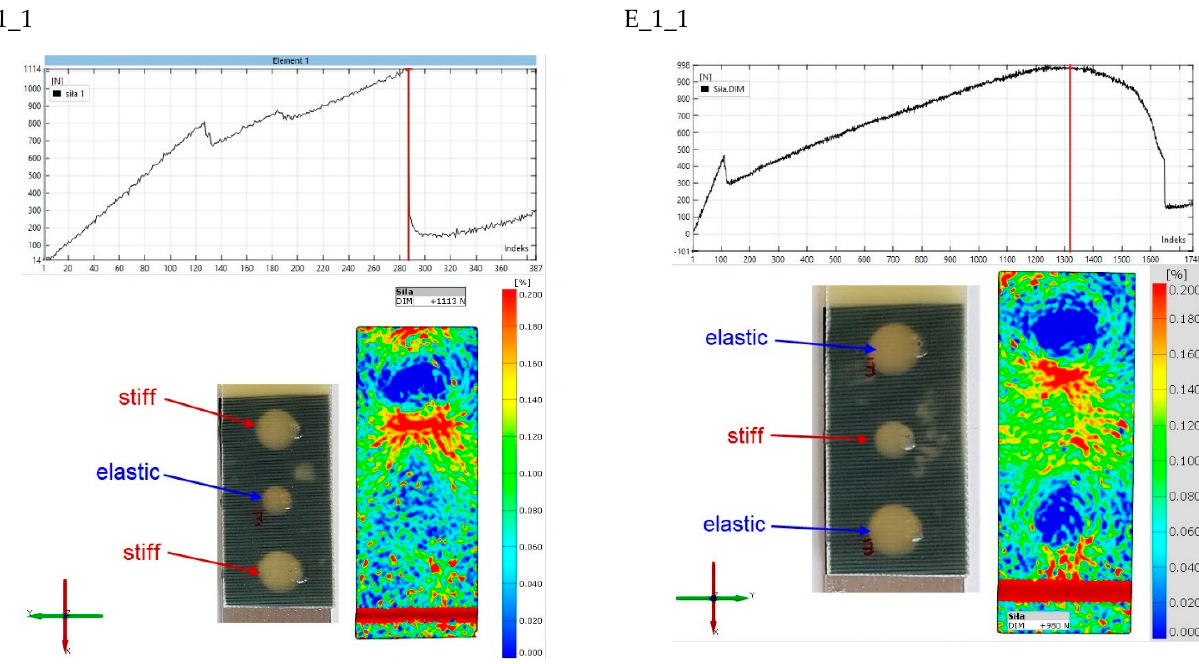
Figure 17. Comparison of principal strain maps for “S” and “E” batch 1 specimens for maximum force in the second stage of operation.